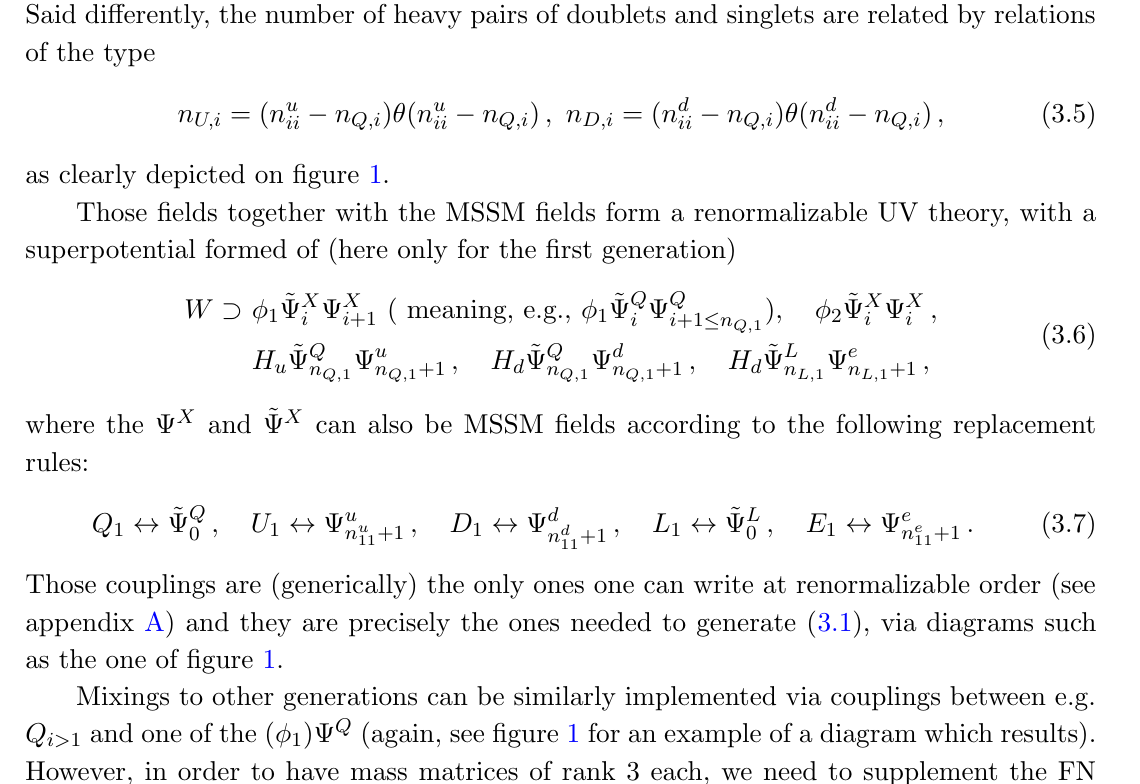
= 6 and n Q; 1 = 4. The gray line 11 = 21